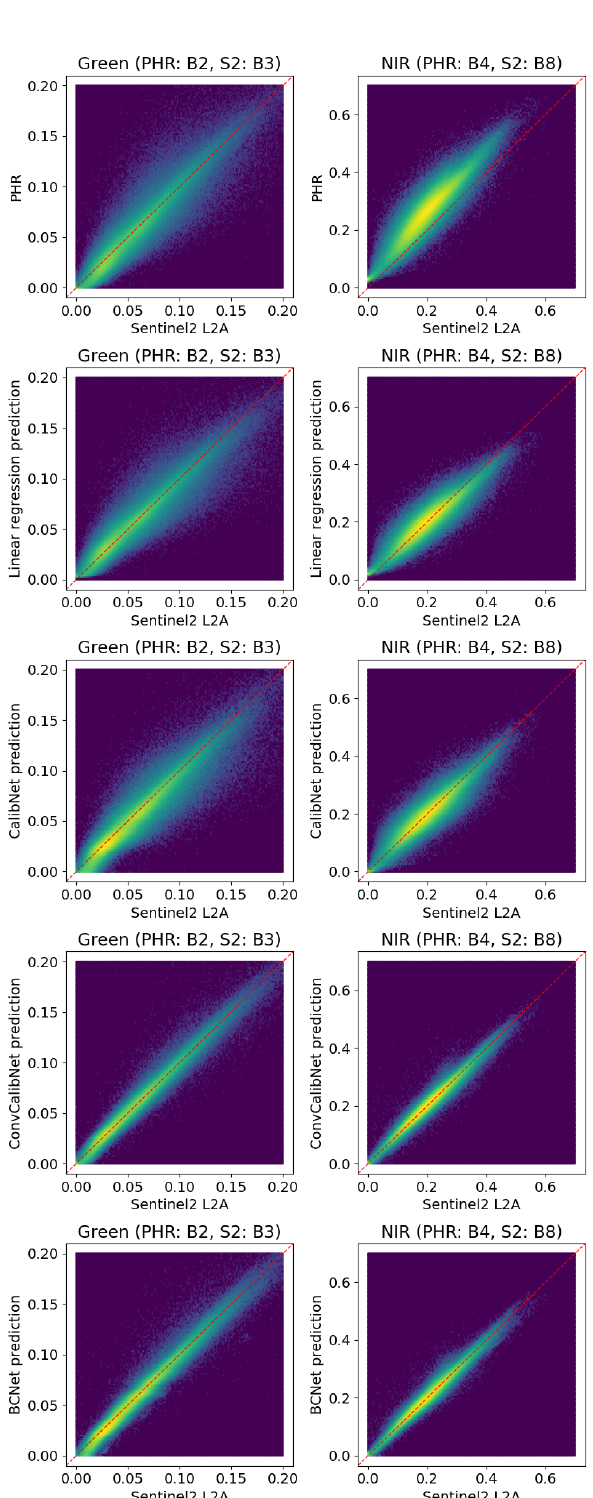
Figure 4. Scatter plot between Pleiades and Sentinel-2 surface reflectance for the Aude1 dataset, for all methods for Green and NIR bands (in this dataset both reflectances are Top of Canopy